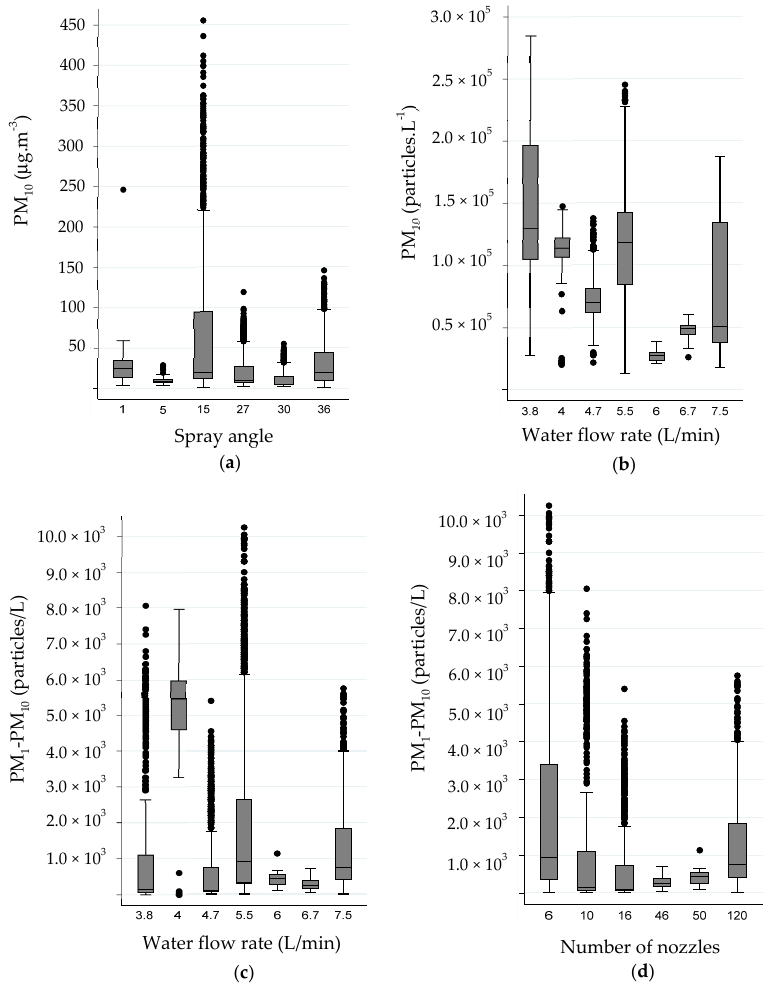
Figure 3. Emission of inhalable particles or water mass in the presence of a mannequin with respect to the spray angle ( a ); the water flow rate (versus PM 10 ) ( b ); the water flow rate (versus PM 1 –PM 10 ) ( c ); and the number of nozzles ( d ). The showers using water-atomization technology were those with a water flow rate of 3.8 to 5.5 L/min, a number of nozzles between 6 and 16, and a spray angle of 27 to 36 degrees. The showers using continuous-flow technology were those with a water flow rate of 6.0 to 7.5 L/min, a number of nozzles between 46 and 120, and a spray angle of 1 to 15 degrees. 4. Discussion Water-atomization showerheads are the most prevalent water-efficient showerheads on the market. To assess the risk of exposure during their usage, we applied the evapora- tion model to the most economical water-atomization showerhead to estimate the number of water droplets of inhalable size emitted by this showerhead. We predicted that this number increased by a factor of two or four depending on whether the RH was 90% or 40%, respectively. The evaporation model also predicted huge increases in the RH and temperature in the experimental shower stall, which was validated experimentally. These findings support the hypothesis that the RH in a shower stall with a water-atomization